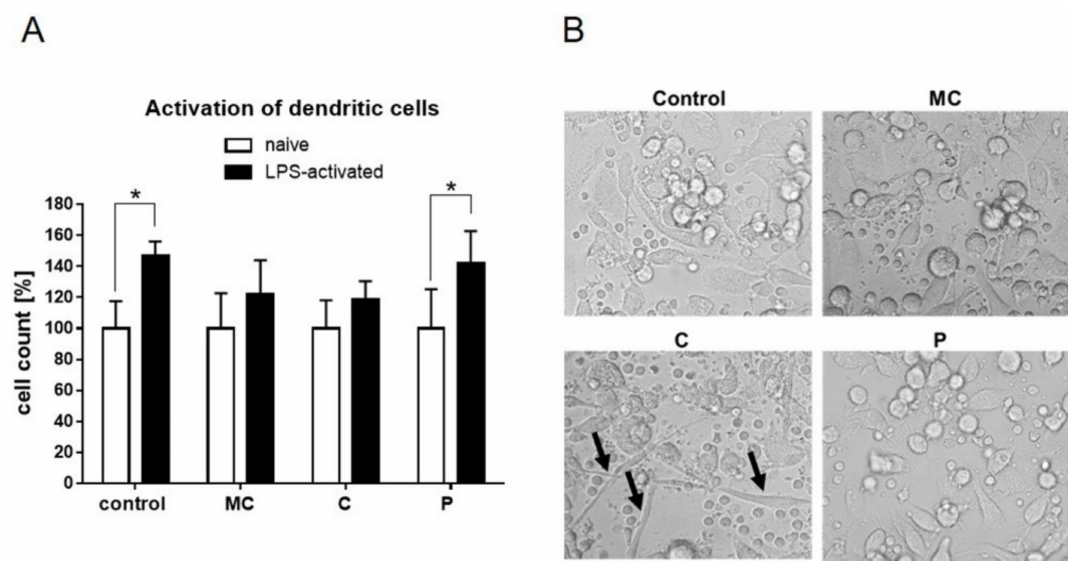
Figure 7. ( A ) Activation of human dendritic cells measured by cell expansion after 24 h stimulation with vehicle, MC extract, C extract, or P extract (60 µ g/mL) in the absence (naïve) or presence of LPS. Naïve cells were set to 100%. ( B ) Representative transmitted light microscopic pictures 24 h after extract stimulation (60 µ g/mL) of naïve human dendritic cells (Magnification 20 × ; black arrows indicate endocytic enlargement). (* p ≤ 0.05; n =